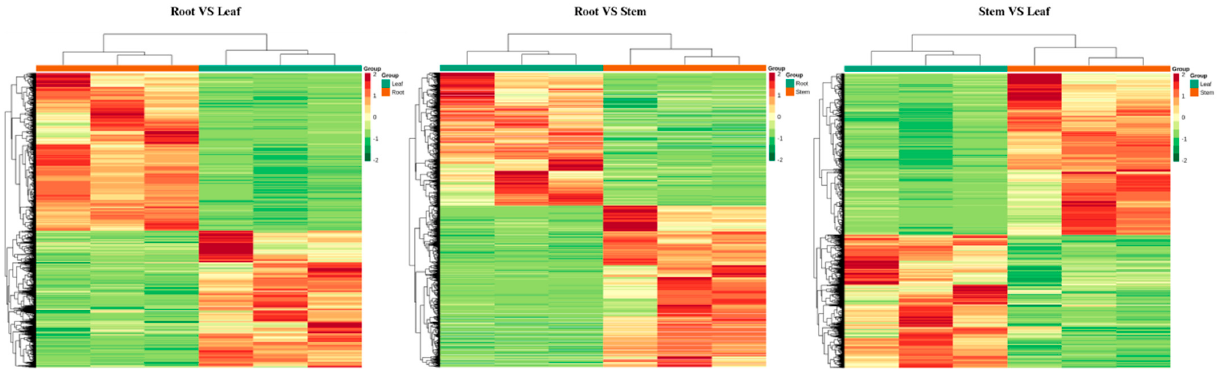
Int. J. Mol. Sci. 2022 , 23 , 5407 Figure 5. Cluster heat map of differential genes in the wild soybean vegetative organ transcriptome.